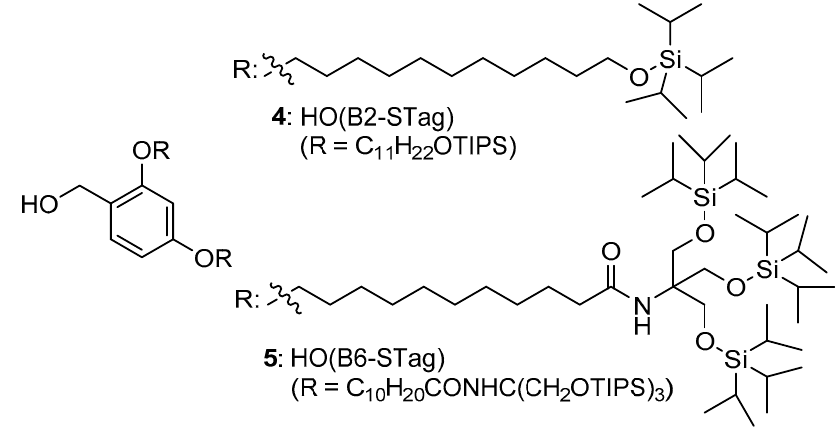
Figure 2. Structure of B2-STag and B6-STag.